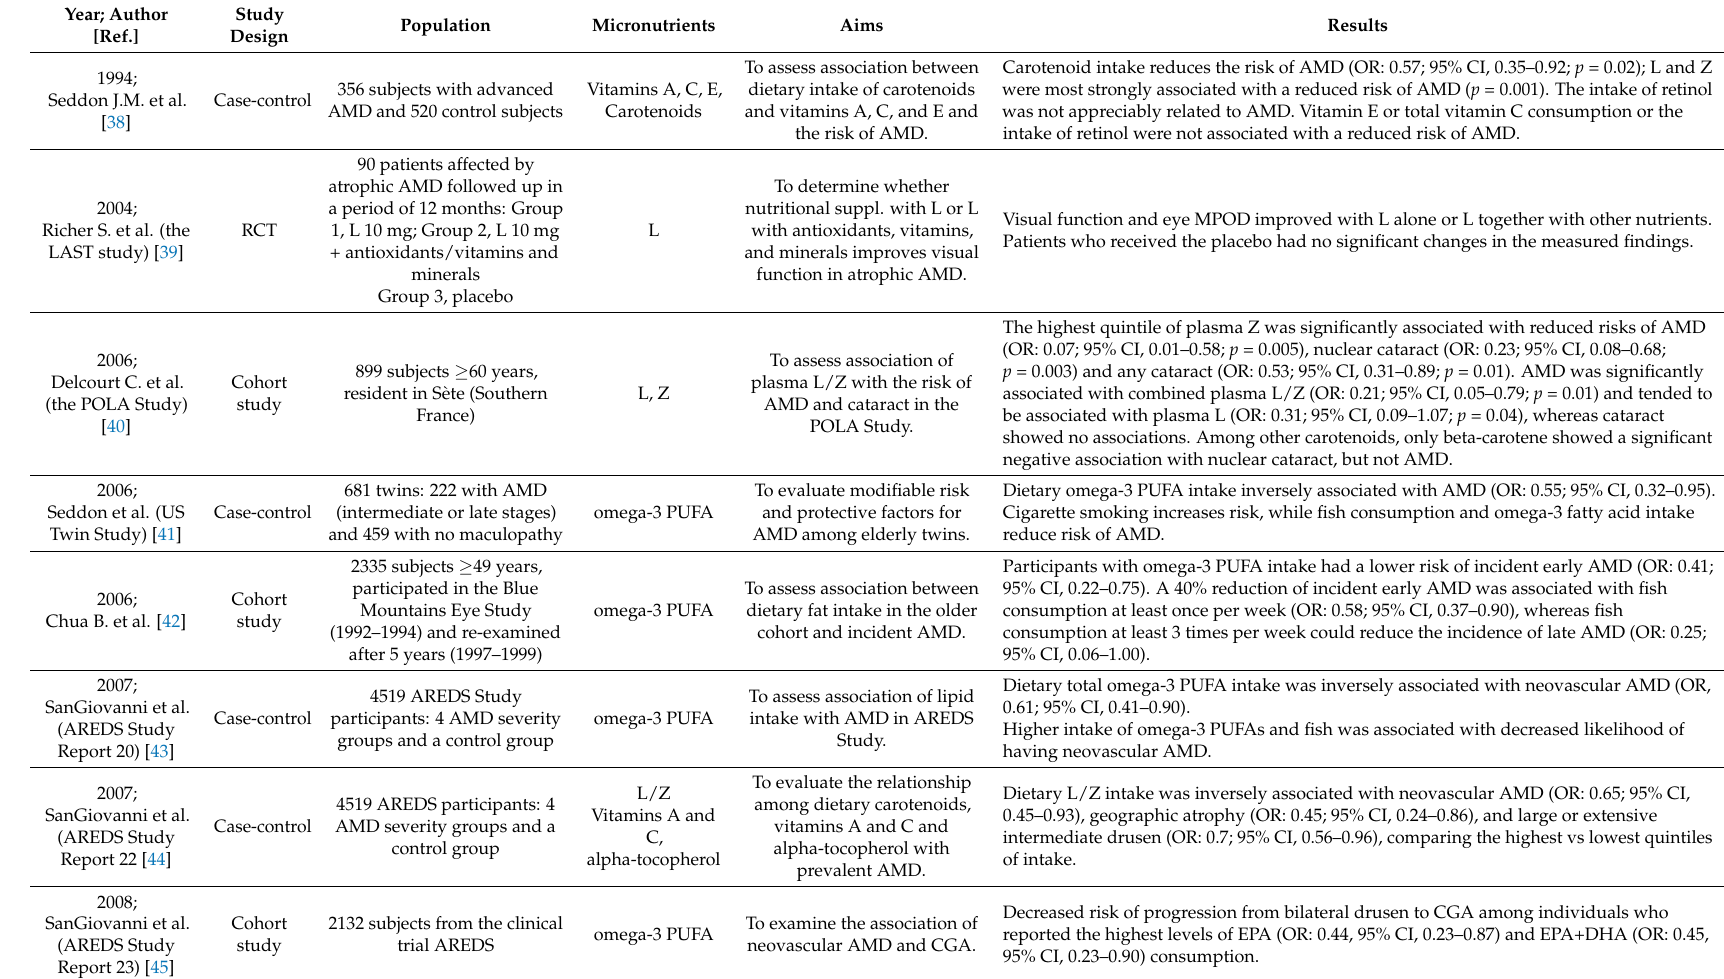
Table 1. Main human studies investigating the role of micronutrients in